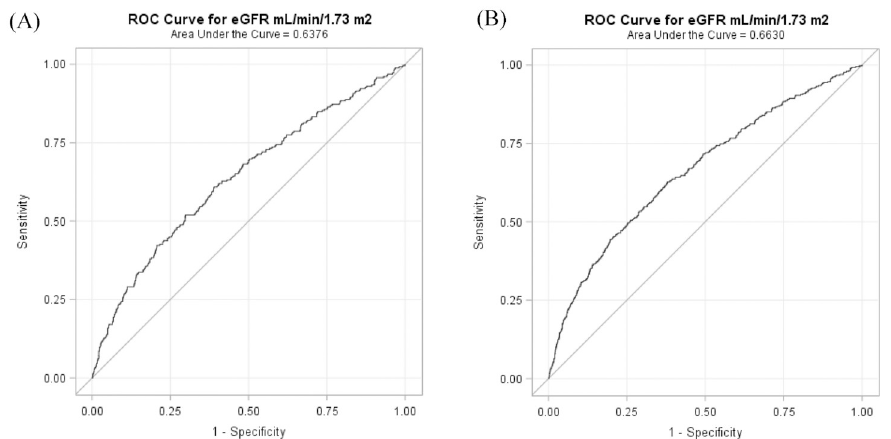
Fig 3. Area under the receiver operating characteristic curves for eGFR levels on admission in predicting 1-month (A) and 1-year (B) mortality in patients with intracerebral hemorrhage.